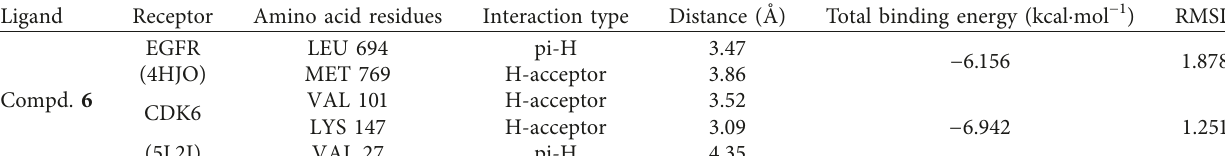
Table 2: Molecular simulation results for ACV/PNV interactions with HAS.